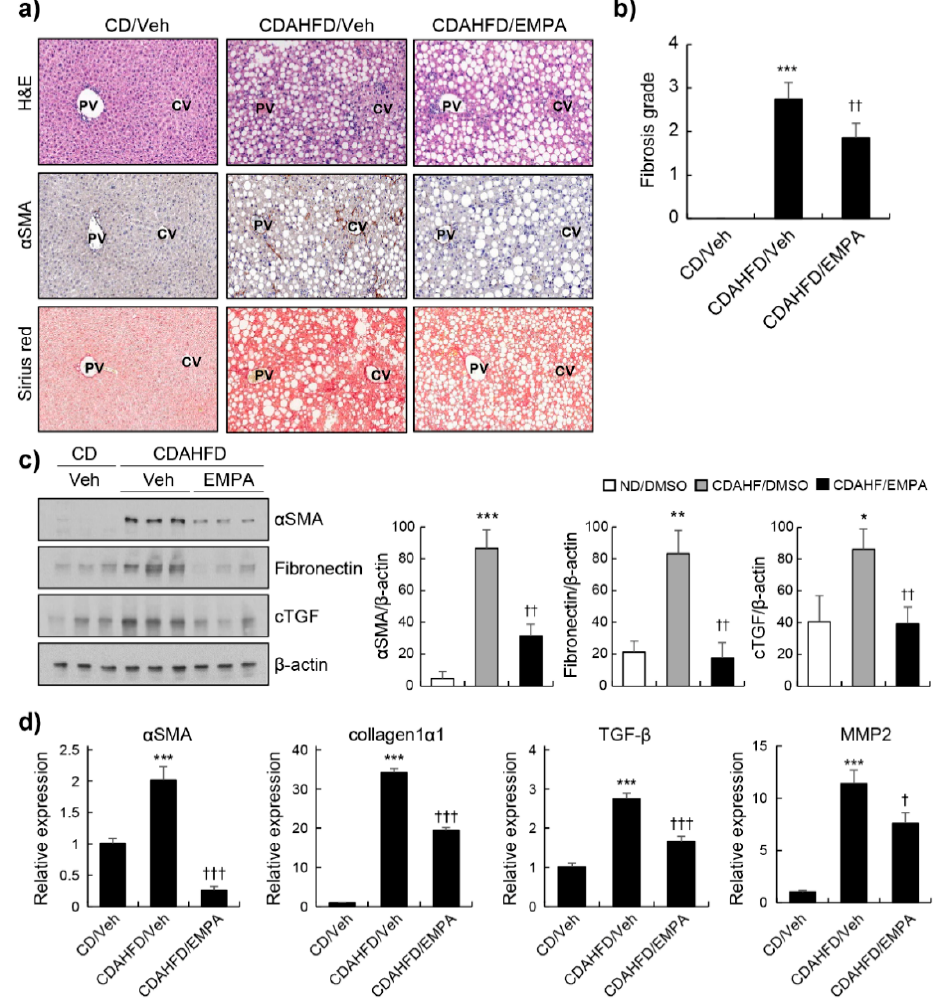
Figure 1. Effects of empagliflozin on hepatic fibrosis in CDAHFD-induced mice. The mice were treated with the control chow diet (CD), choline-deficient, L-amino acid-defined, high-fat diet (CDAHFD), or CDAHFD with empagliflozin (EMPA) treatment. ( a ) The liver histology was studied via macroscopic morphological examination, H&E staining, and Sirius Red staining. α -SMA signals were visualised via immunohistochemistry. ( b ) Fibrosis grades in the different groups. ( c ) α -SMA, fibronectin, and connective tissue growth factor (cTGF) signals were examined and quantified using Western blot. β -actin served as the loading control. ( d ) Relative expression of genes related to fibrosis was determined via RT-PCR. * p < 0.05, ** p < 0.01, and *** p < 0.001 in the comparisons of the CD-fed mice with the CDAHFD-fed mice. † p < 0.05, †† p < 0.01, and ††† p < 0.001 in the comparisons of the CDAHFD ‐ fed mice with the EMPA treatment groups. PV: portal vein; CV: central vein.